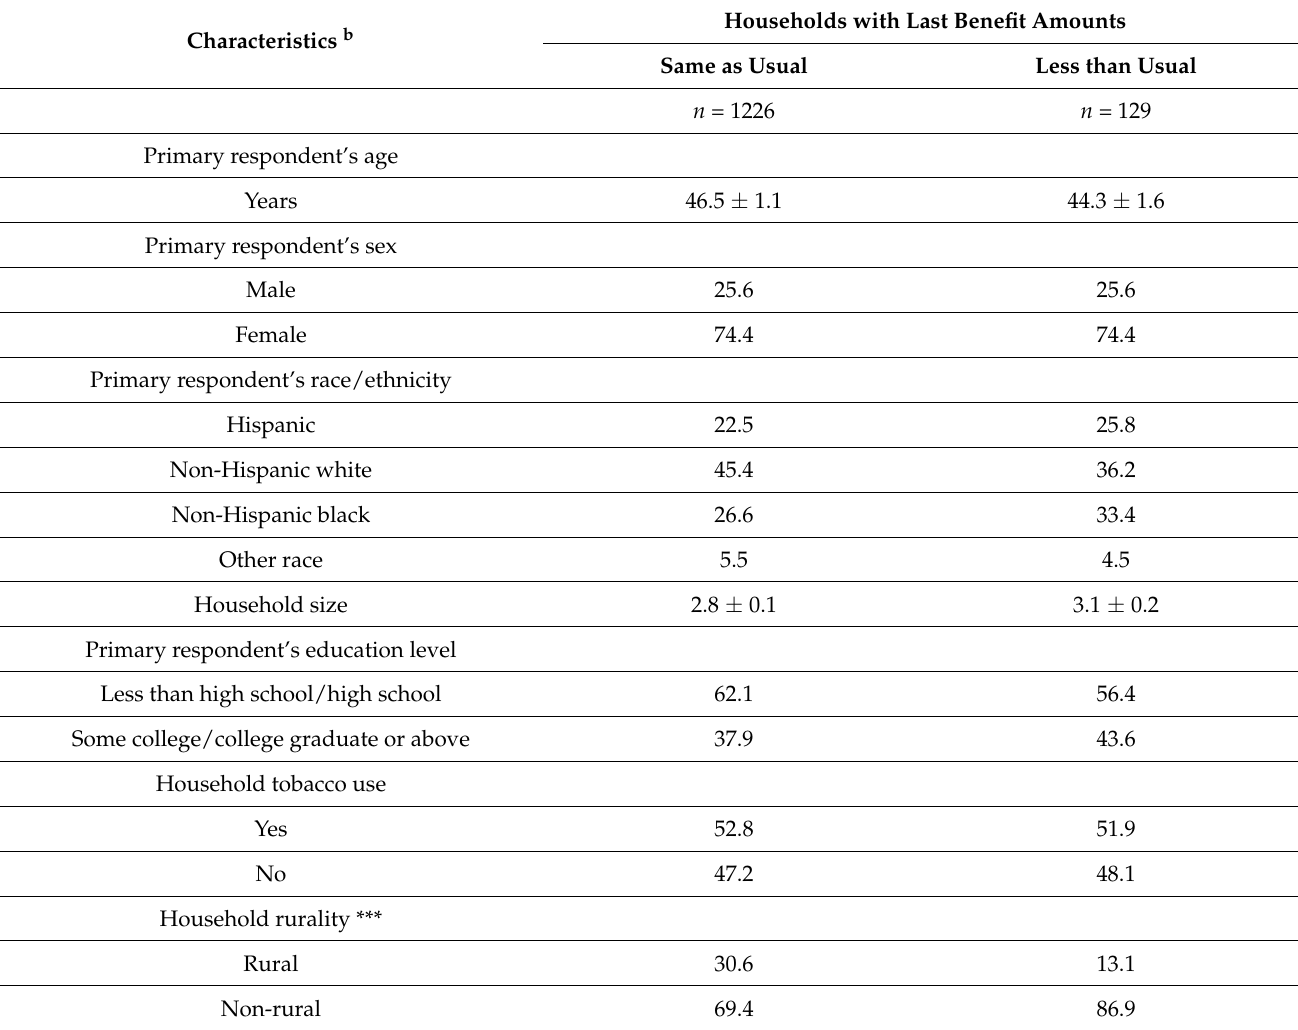
Table 2. Household demographics a by Supplemental Nutrition Assistance Program (SNAP) benefit amount. Characteristics